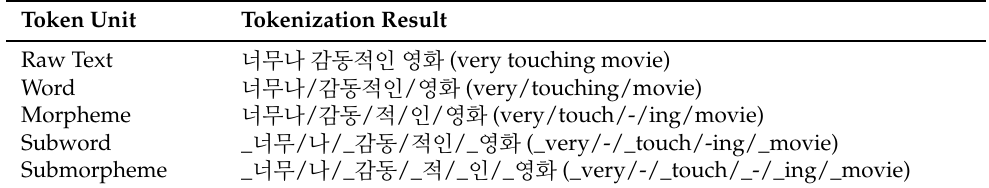
Table 1. Example of tokenization results according to token units for “ 너 무 나 감 동 적 인 영 화 ” (very touching movie); We marked the token, which is we can not represent in English, as “-” (hyphen). Token